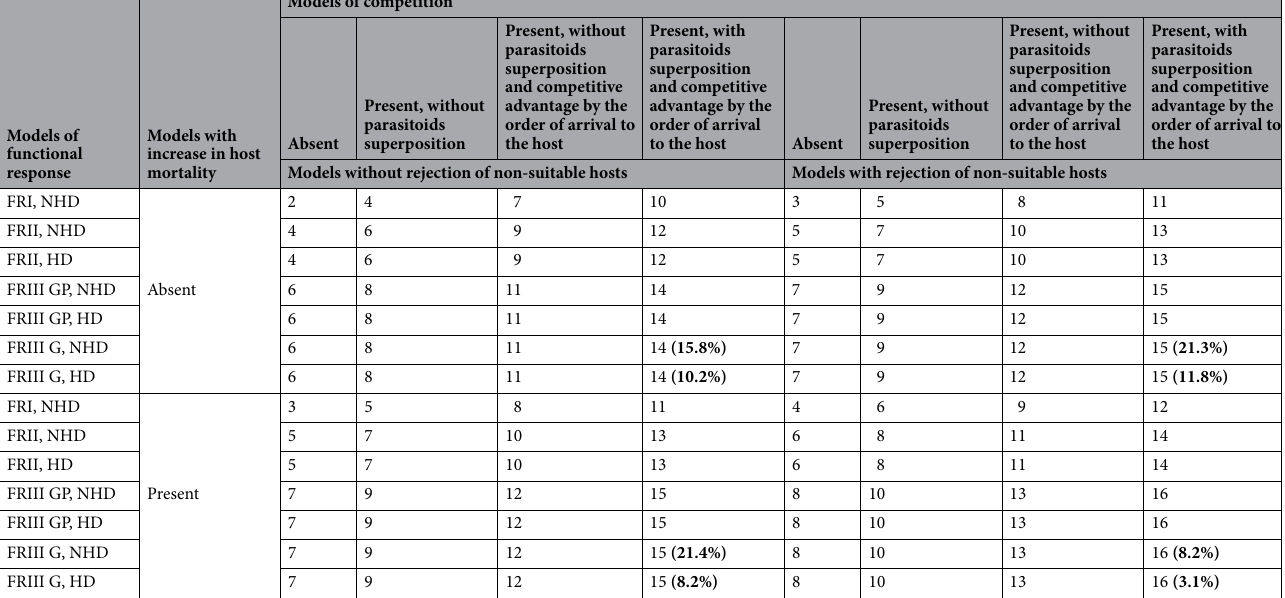
Table 2. Proposed models analyzed to identify the kind of interactions (competition and intraguild predation) between two species of Hypogeococcus sp. parasitoids, Anagyrus cachamai and A. lapachosus . Combinations of models were tested resulting in 112 different models (see Supplementary for model development). Values are the number of parameters for each model combination, and in bold and parenthesis the weight of the eight selected models for model averaging after 20,000 reversible jump iterations. NHD identified models without host depletion and HD with host depletion. GP: order two polynomial generalized type III functional response; G: generalized type III functional response.